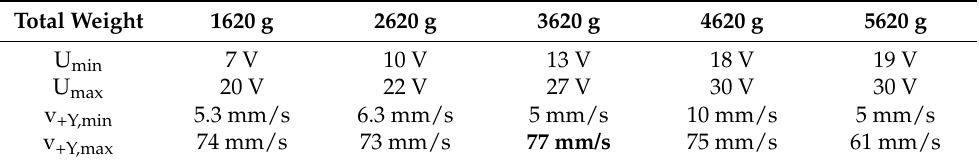
Figure 10. Measurement results of the drive velocity 𝑣(cid:3548) (cid:2878)(cid:3026) of the planar motor platform in the +Y direction for different transport load scenarios